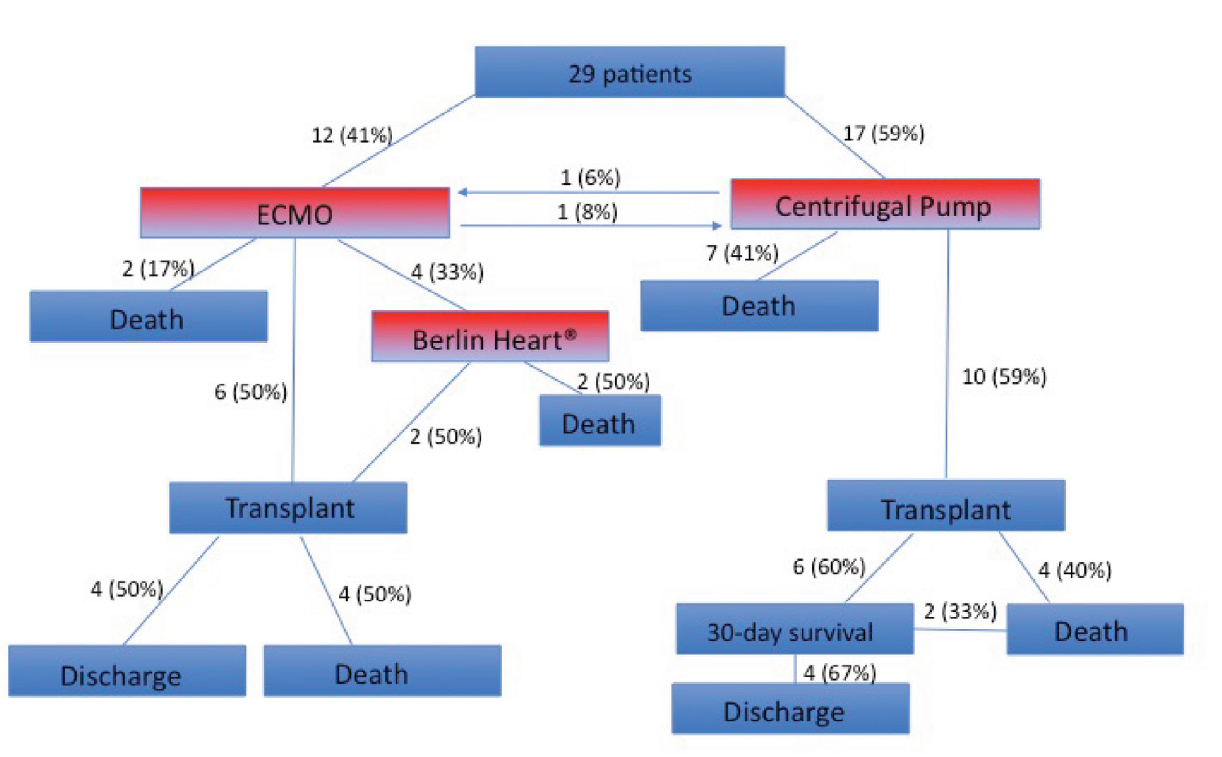
Fig. 1 – Outcomes in INTERMACS level 1 and 2 Pediatric and Congenital Heart Transplant waiting list patients connected to MCS.